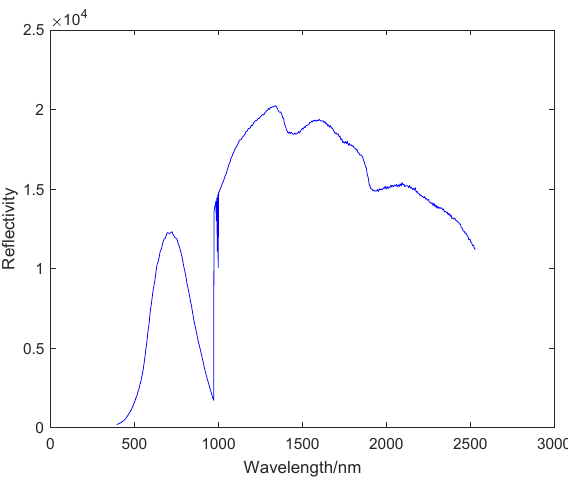
Figure 4. The original waveform of full-spectrum.